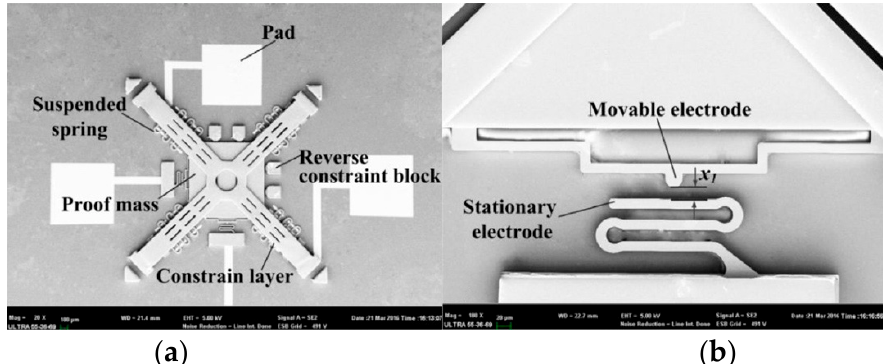
Figure 11. SEM images of ( a ) an inertial micro-switch with a flexible movable electrode and a stationary electrode in the double-stair and spring-shape structures, and ( b ) the close-ups of synchronous follow-up compliant electrodes [63].